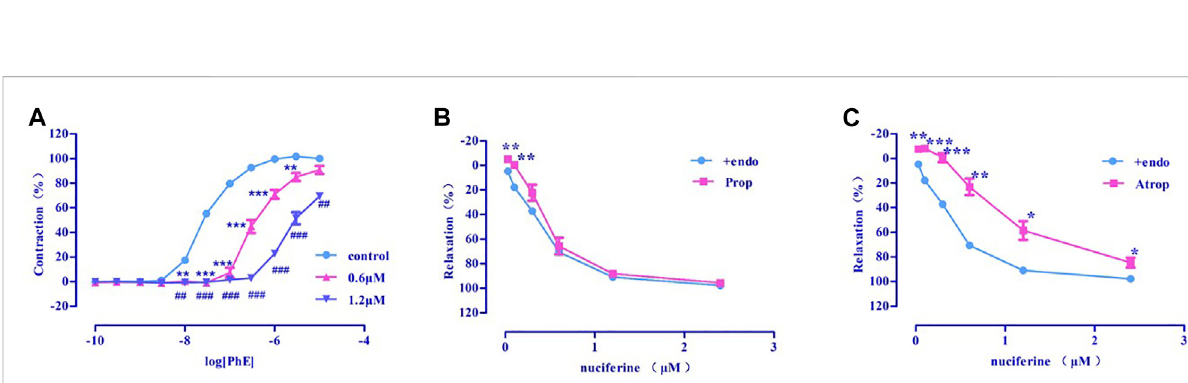
The vasodilation effect of nuciferine (A) Intact endothelium (+endo); (B) . Endothelium-denuded (-endo); (C) ±endo. The data are expressed as the means ± SD. of 6 – 8 rats (n = 6 – 8). (* p < 0.05; ** p < 0.01 and *** p < 0.001 vs. control group).